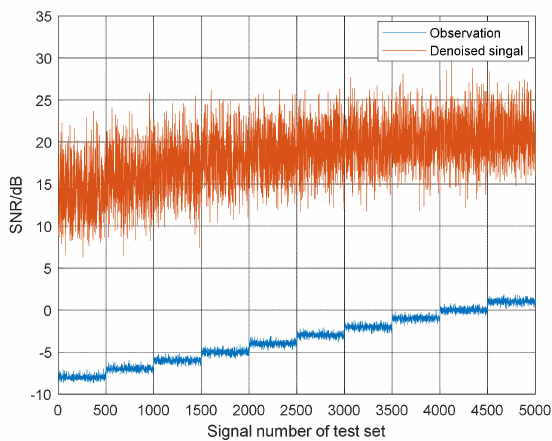
Figure 9. The SNR of observations and denoised